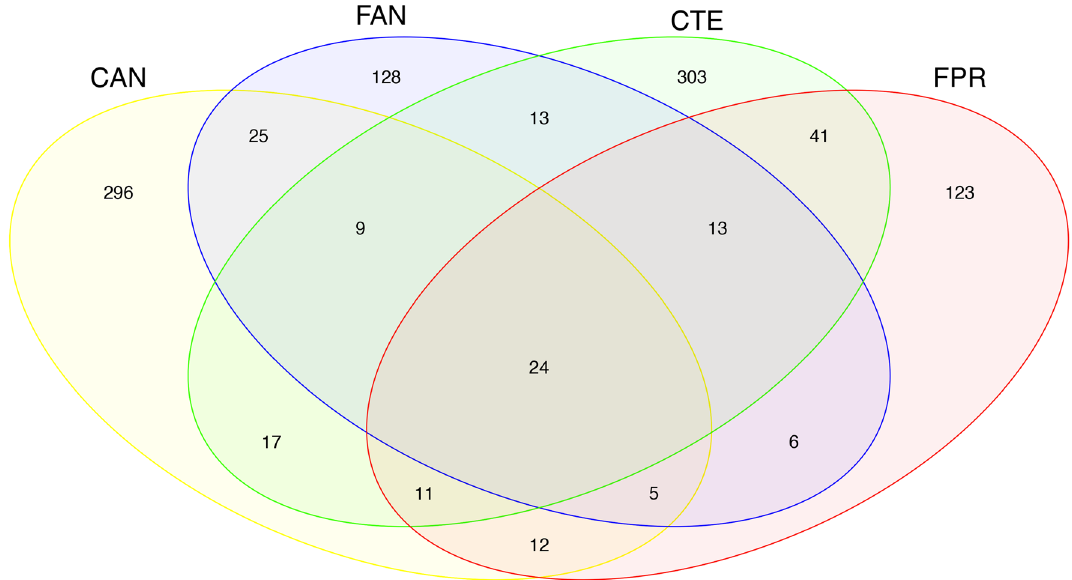
Figure 4. Venn diagram showing the shared and unique OTUs of the microbiomes associated with the four Antarctic springtail species. Sample labels are expanded in Table 1. The figure was generated using the R package gplots v3.0.1.1 (https ://CRAN.R-proje ct.org/packa ge=gplot